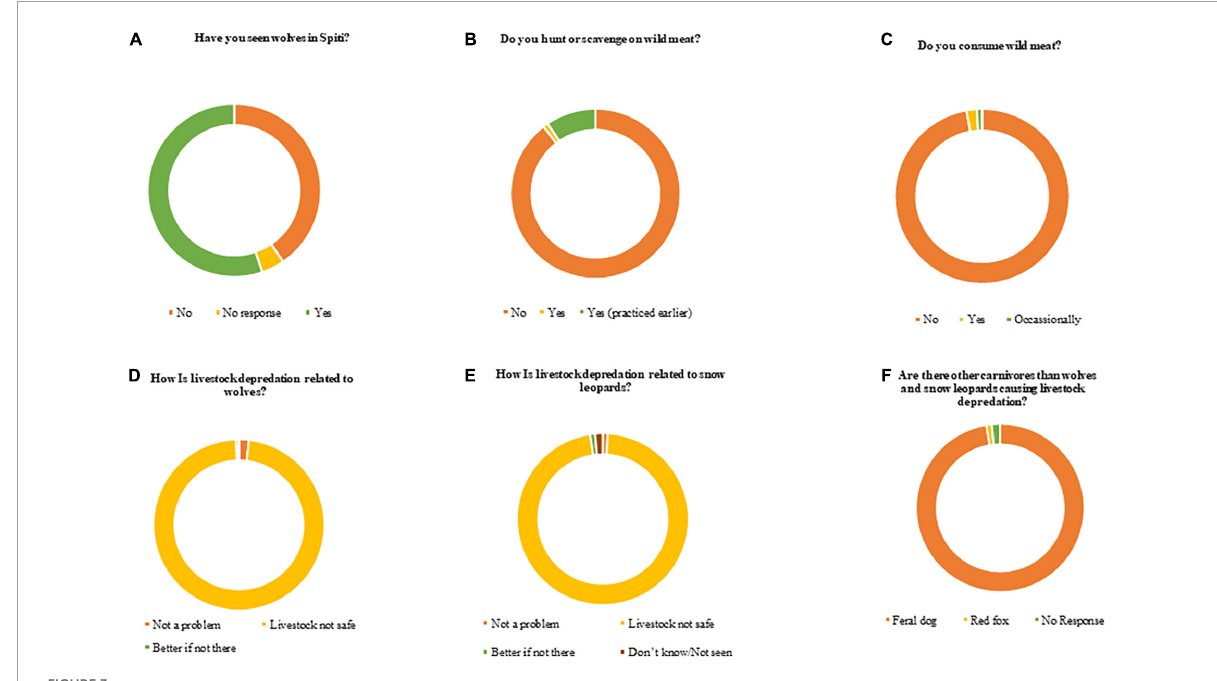
FIGURE3 Attitudes and response of households with respect to questionnaire surveys on wolf conflict in 35 villages ( n = 200).